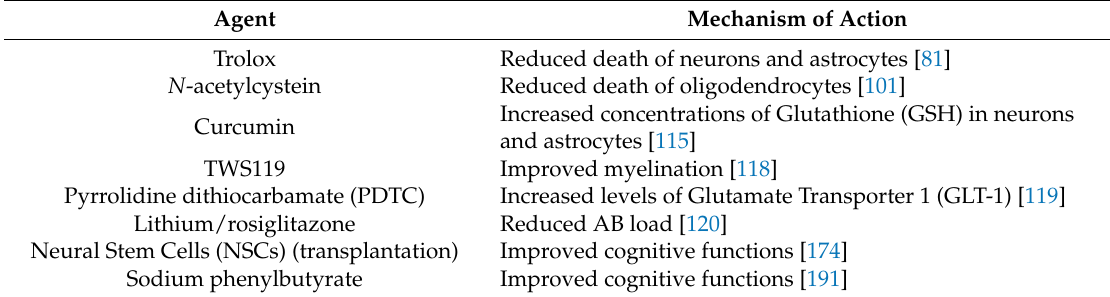
Table 2. A summary of the agents that may have therapeutic applications in